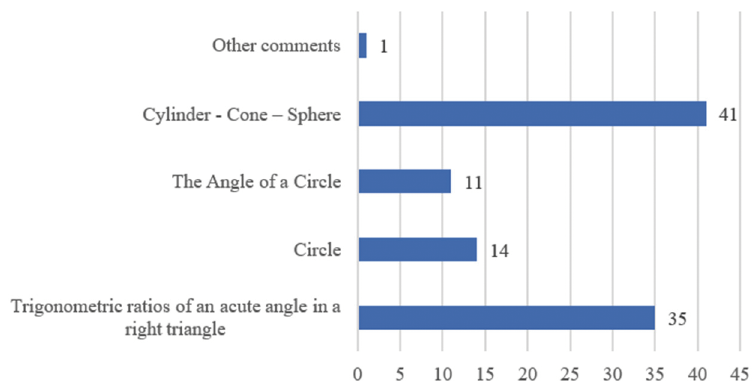
Figure 2. Geometric theme Mathematics 9 can be designed according to STEM